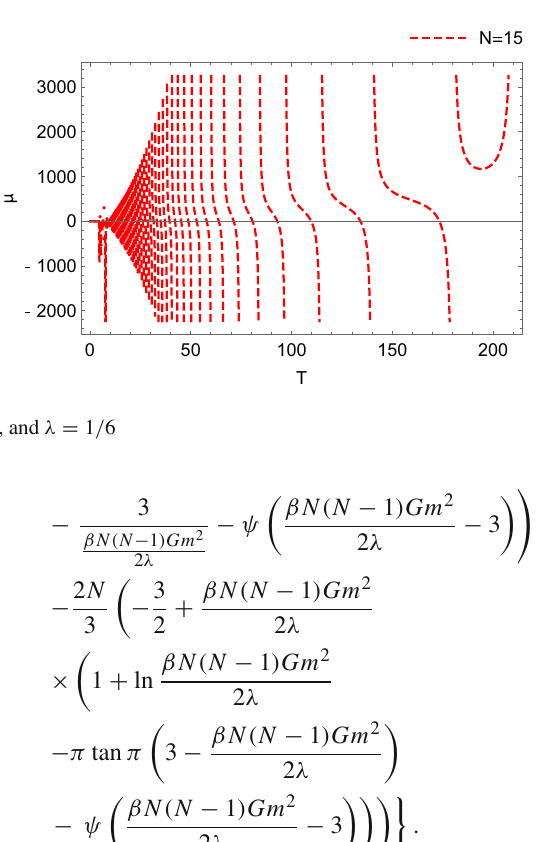
Fig. 5 State equation in terms of temperature with G = m = k = 1, and λ = 1 / 6